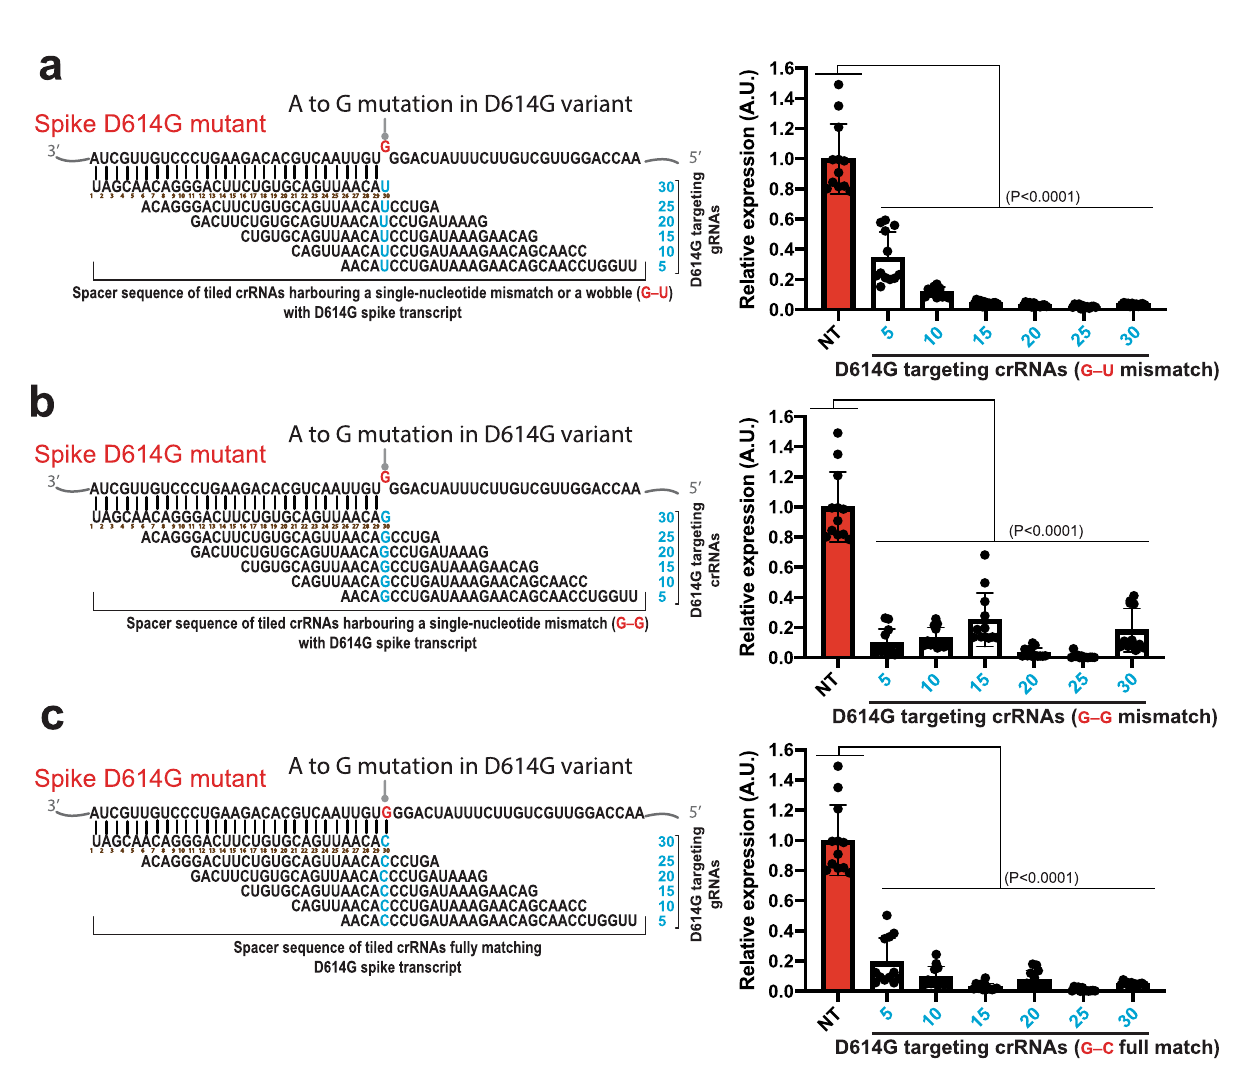
Fig. 5 Single crRNAs targeting the D614 genomic mutation hotspot can silence D614G variant ’ s RNA through the single-nucleotide mismatch tolerance. a – c Fluorescence-based reporter assay to assess the silencing ef fi ciency of the D614G Spike transcripts with 18 tiled crRNAs harbouring a G – U ( a ), G – G ( b ) single-nucleotide mismatch, or G – C full match ( c ) with the target at various spacer positions; Data points in the graphs are mean fl uorescence from 4 representative fi elds of view per condition imaged; N = 3. The data are represented in arbitrary units (A.U.). Errors are SD and p -values of one-way Anova test are indicated (95% con fi dence interval). N is the number of independent biological experiments. Source data are provided as a Source data fi le.